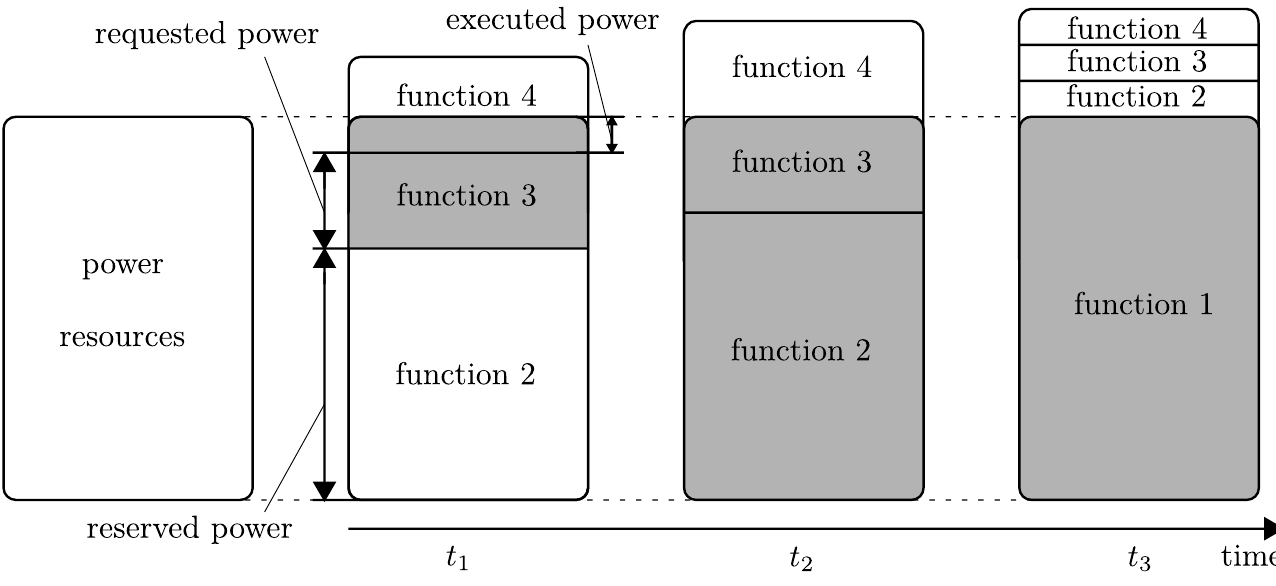
Figure 4. Concept of dynamic prioritization of